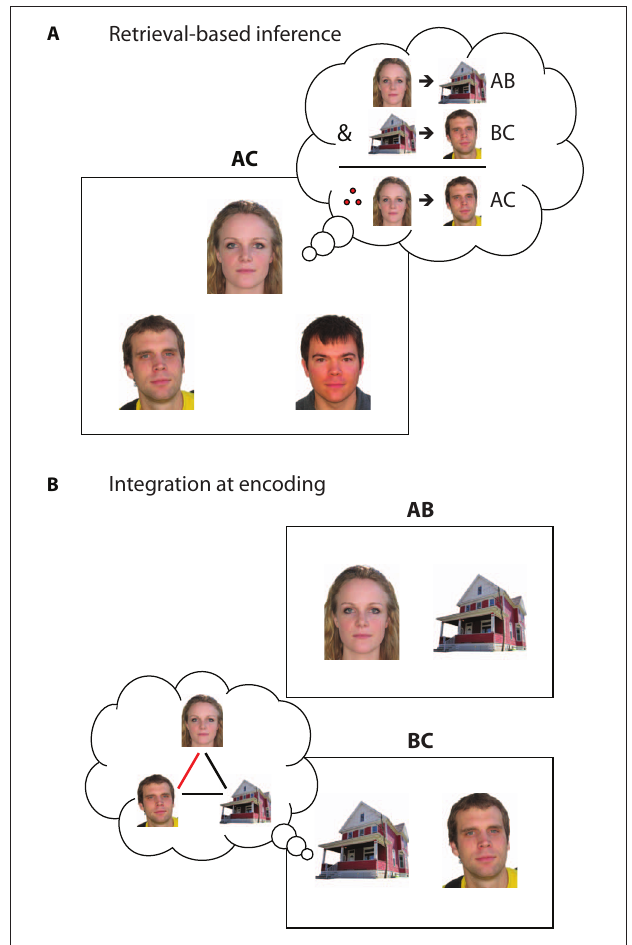
FIGURE 3 | Symbolic depiction of encoding and retrieval strategies that may support inference. (A) Retrieval-based inference through recall and recombination of individual memories. When encountering a novel inferential probe (e.g., AC), the individual elements may trigger hippocampal pattern completion mechanisms, leading to the retrieval of the previously encountered overlapping associations (AB, BC) that can be then recombined to answer novel questions. In this example, when having to select which of the two men lives with the woman, one can recall that the woman lives in the red house, and that the man on the left also lives in the red house. Therefore, the woman lives with the man on the left. (B) Integration of overlapping events during encoding. When encountering an event that overlaps with prior experience (e.g., experiencing BC after encountering AB), the overlapping element (B) may trigger hippocampal pattern completion, reactivating the prior memory. The current experience may then be encoded in the context of the reactivated memory to form an integrated (A-B-C) representation that combines elements from both events. In this example, the prior memory for the woman living in the red house may be reactivated when learning about the man living in the same house. The current and reactivated experiences can then be combined to form a novel association that the man and the woman live